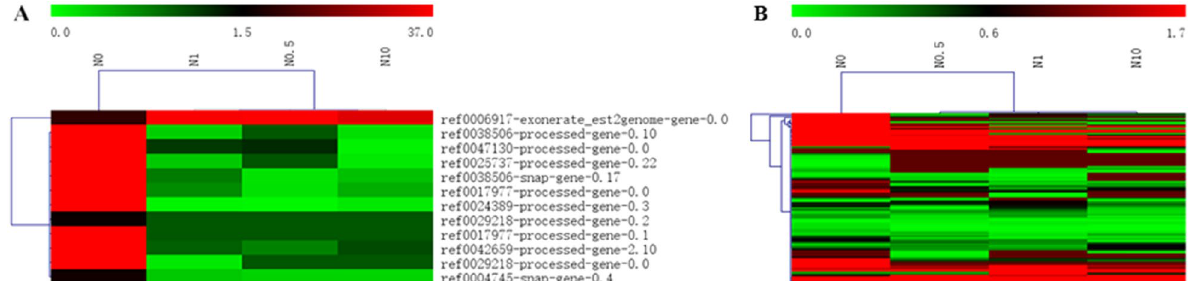
Figure 9. Heat map clustering analysis of DEGs involved in the nitrogen metabolism pathway and the NRT family. ( A ) represents the clustering of DEGs enriched in the nitrogen metabolism pathway. ( B ) represents the clustering of DEGs classified into the nitrogen transporter gene family. High-expression genes are shown in red, and low-expression genes are shown in